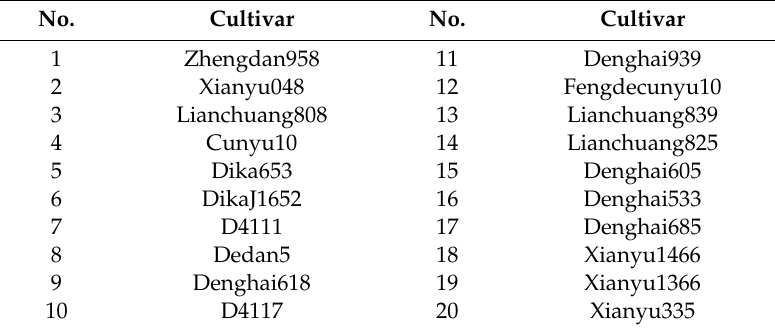
Table 1. The 20 selected maize cultivars. Table1. The 20 selected maize cultivars.